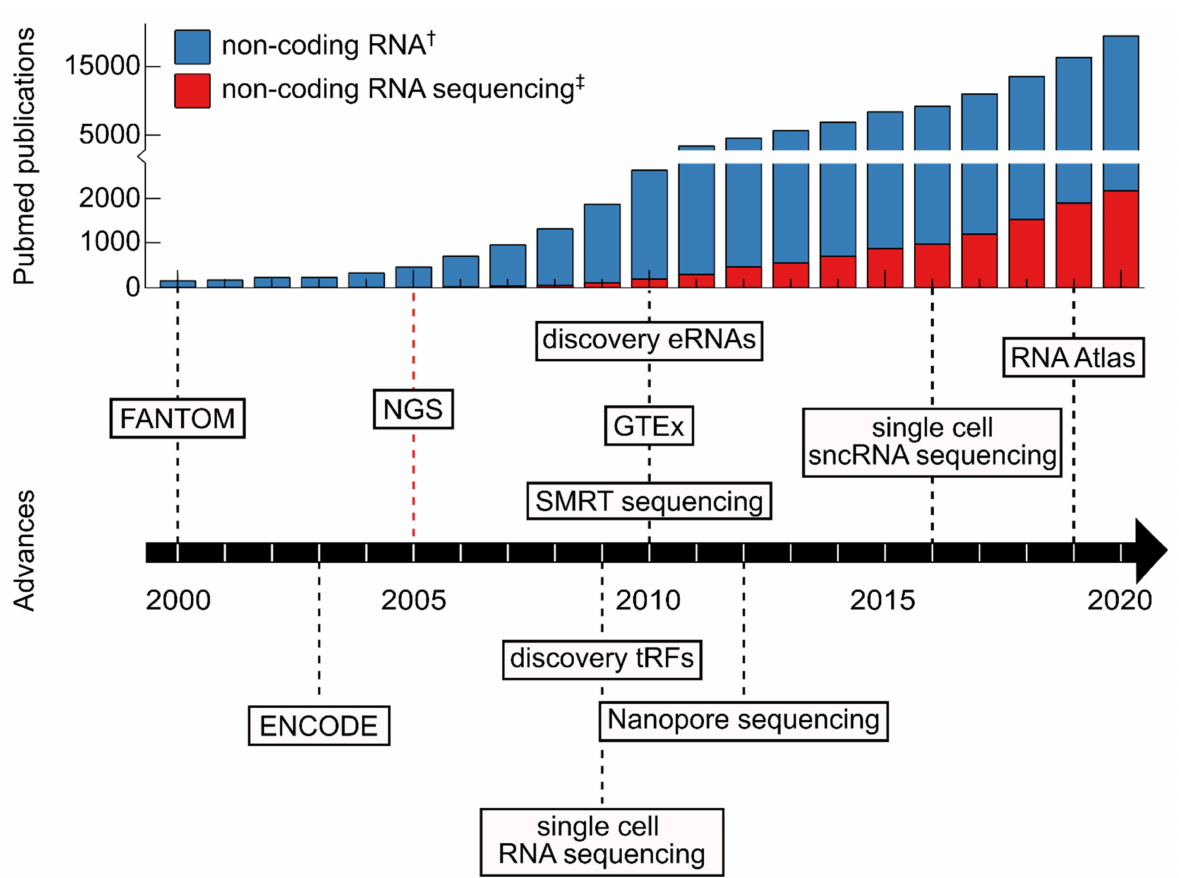
Figure 1. Important advances in non-coding RNA research over the last two decades. The bar chart presents the numbers of publications with the topics “non-coding RNA” and “non-coding RNA sequencing” per year according to the timeline represented as an arrow. ( † Pubmed search for “ncRNA” OR “miRNA” OR “piRNA” OR “snoRNA” OR “snRNA”